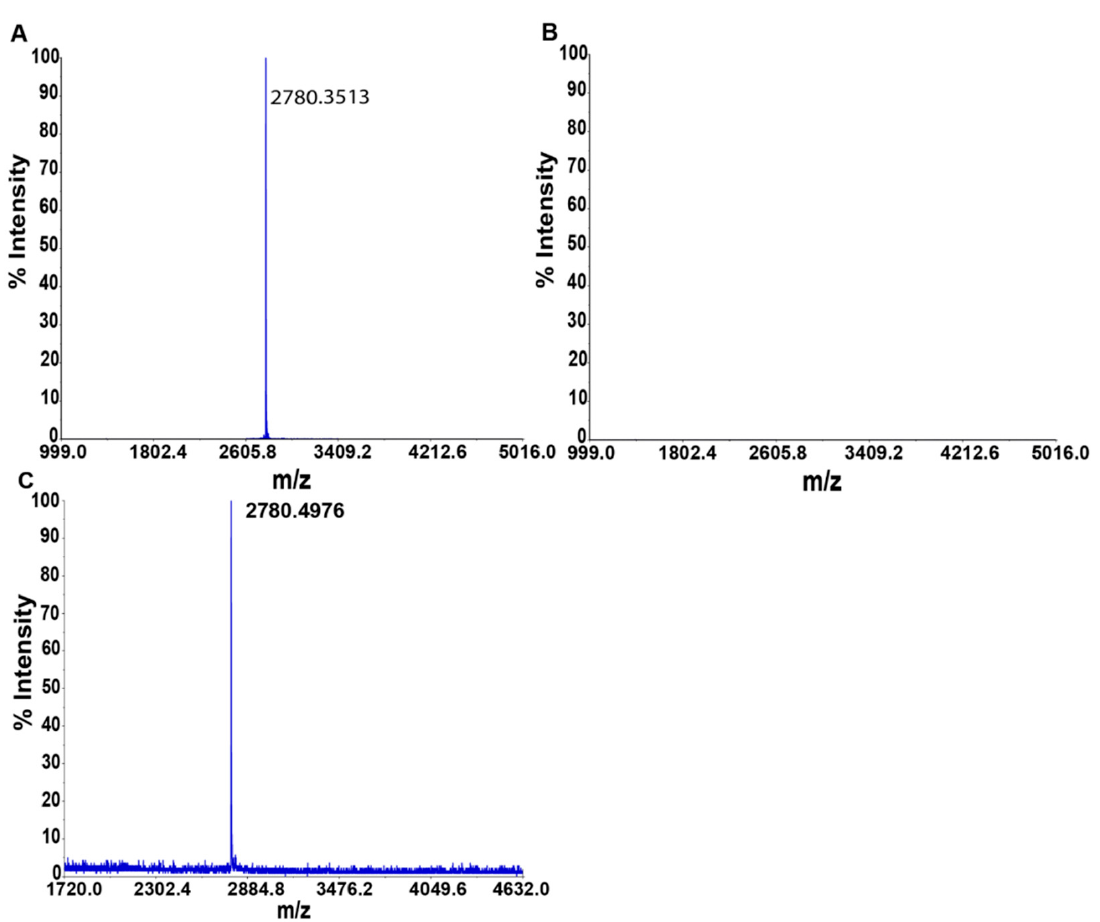
Figure 5. Affinity test results for the HVEM (14–39) peptide in a microcolumn with immobilized BTLA-Fc protein. The figure shows: ( A ) supernatant; ( B ) last wash; and ( C ) elution.